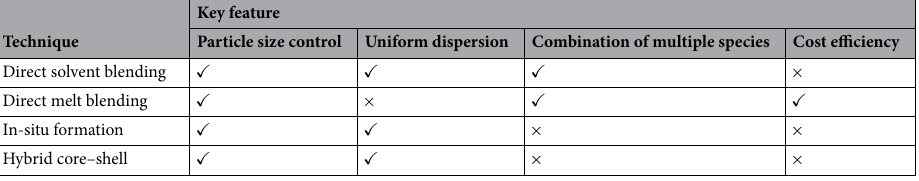
Table 4. Key features of alternative fabrication